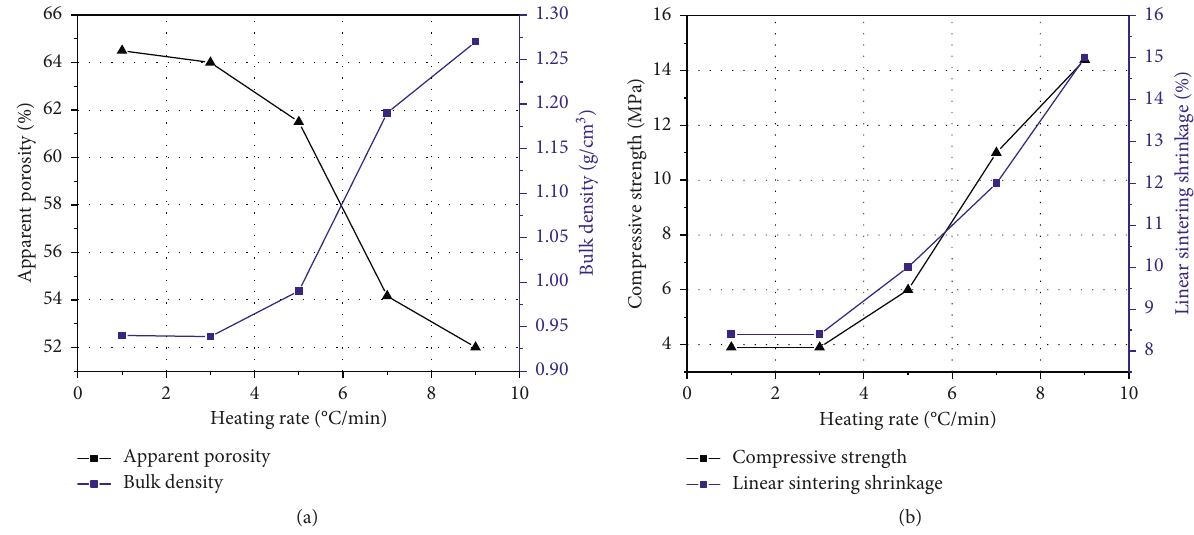
Figure 8: The influence of the heating rate on (a) the apparent porosity and bulk density and (b) compressive strength and linear sintering shrinkage of as-sintered ceramics for the second-stage sintering process.